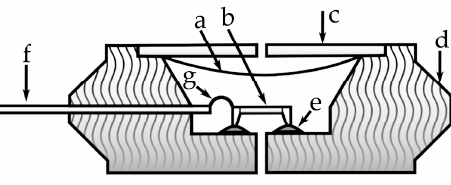
Figure 2. MEMS technology pressure sensor cross-section: a—protective gel cover; b—silicon membrane; c—metal part of the cover; d—main cover; e—measuring the structural place of the attachment; f—signal output; g—pins [2].